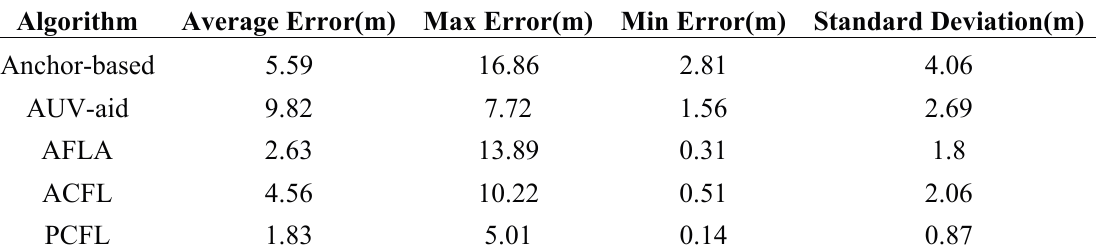
Table 4. Comparison of localization